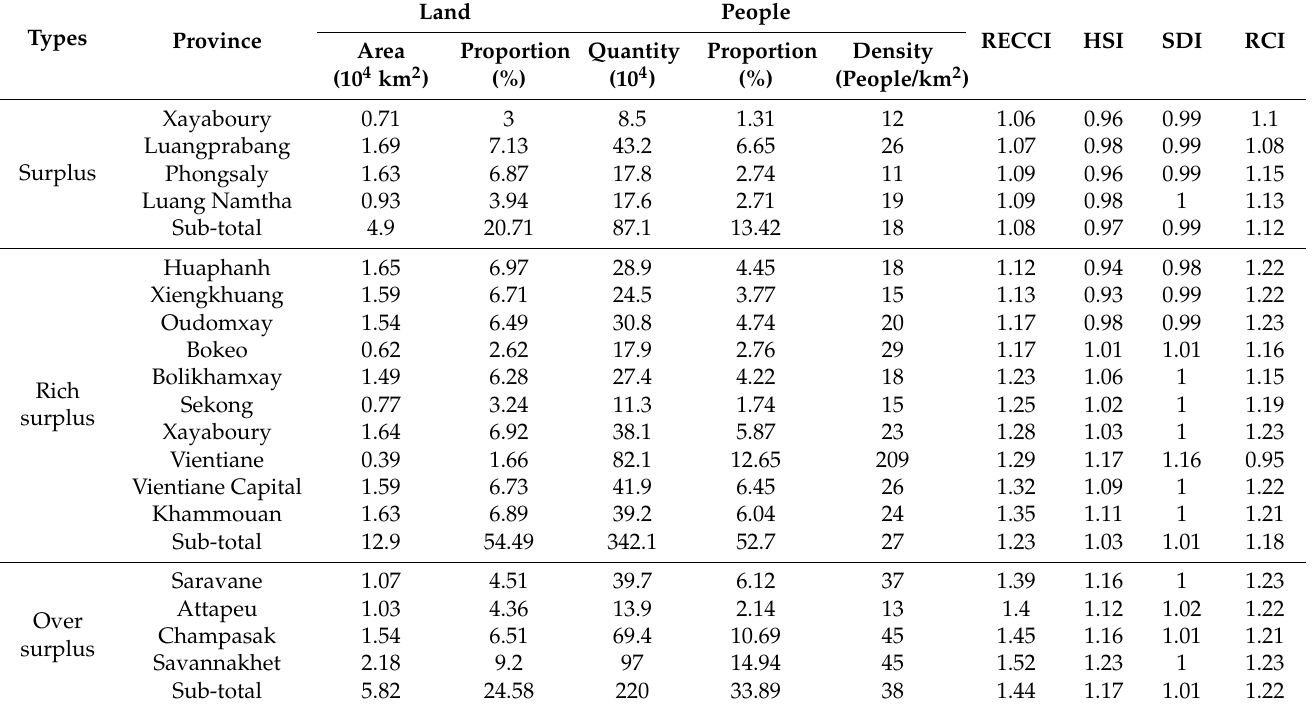
Table 5. Comprehensive bearing status of resources and environment in